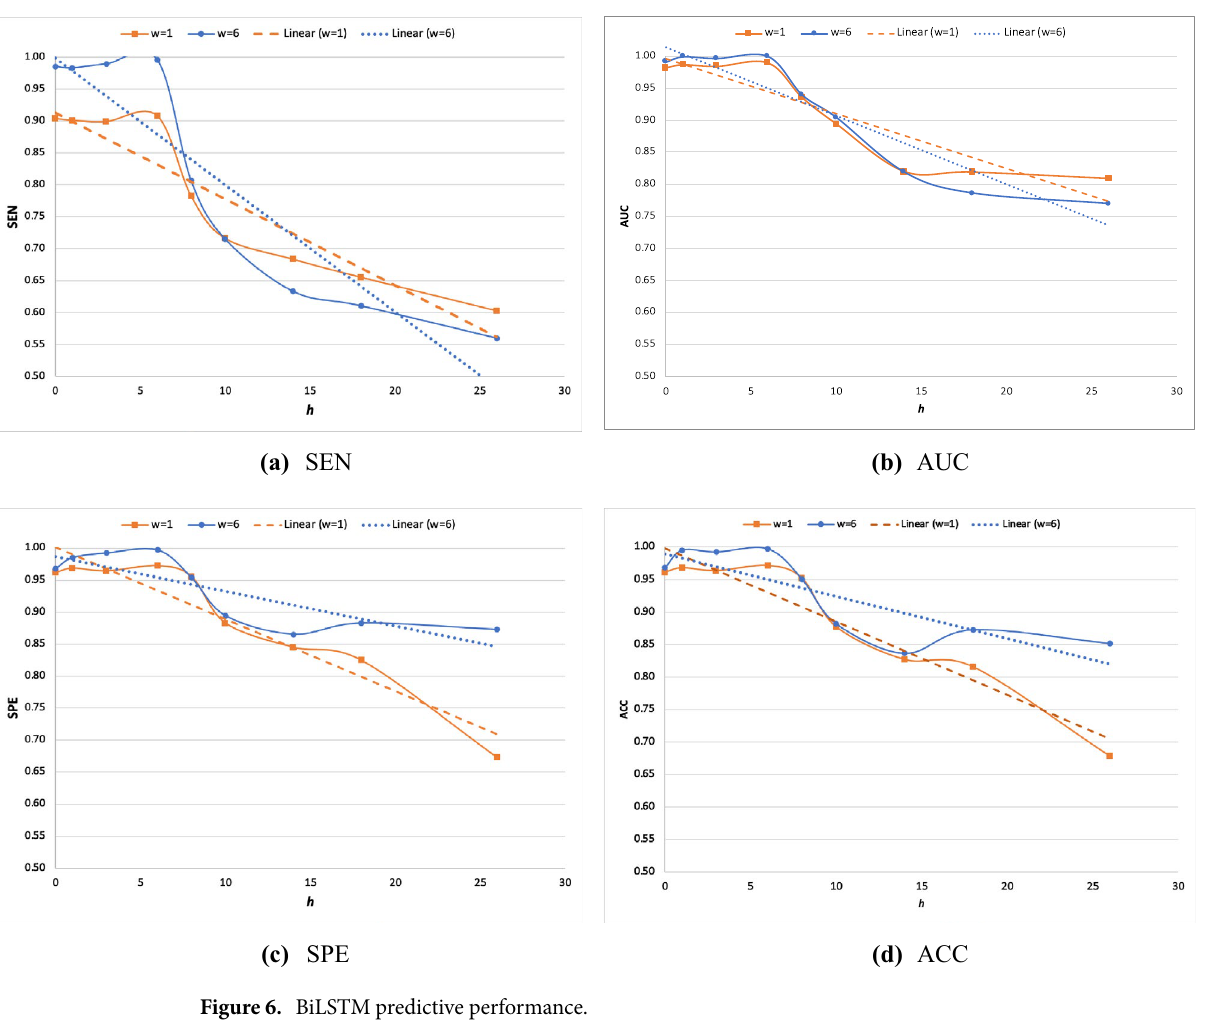
Figure 6. BiLSTM predictive performance.